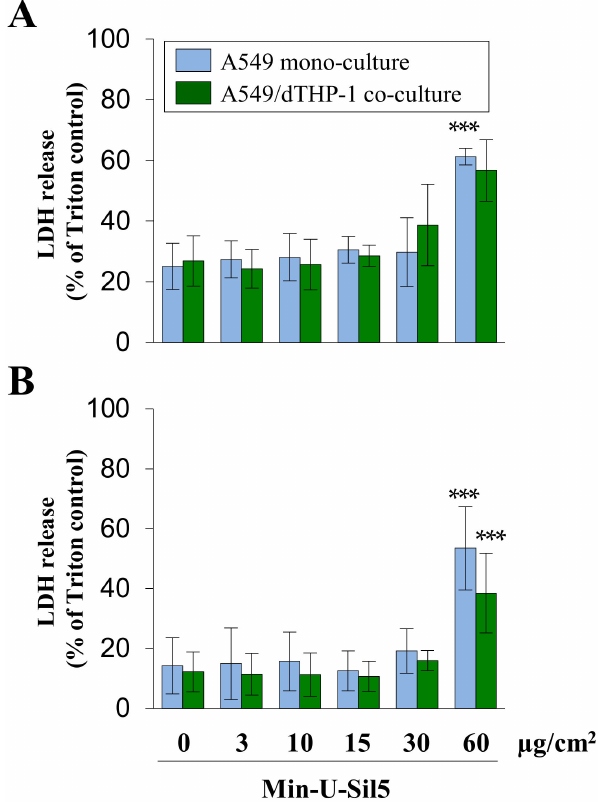
Figure 4. Assessment of cytotoxicity in A549 mono- and A549/dTHP-1 co-cultures after submerged exposure to Min-U-Sil5 in the absence ( A ) or presence of FBS ( B ). A549 cells were seeded with a density of 2 × 10 5 /cm 2 . After 4 h, dTHP-1 cells (2.95 × 10 4 /cm 2 ) were seeded on top of the A549 cells for co-culture treatment. On the next day, mono- and co-culture were treated with 3, 10, 15, 30, or 60 µ g/cm 2 (3, 9, 30, 45, 90, or 180 µ g/mL) Min-U-Sil5 for 24 h. The supernatants were analyzed for LDH release. LDH release is depicted relative to the Triton control (100%). The means ± SD of at least three independent experiments performed in duplicates are displayed. Statistical analysis was performed to assess differences between treated and untreated cells using student’s t -test: *** ( p ≤